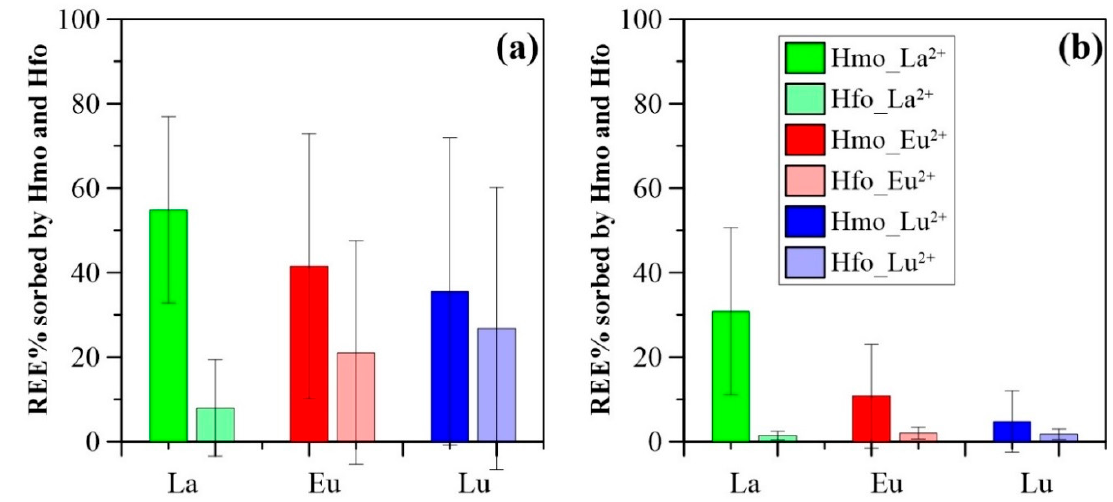
Figure 9. Comparison of sorbed La, Eu, and Lu by HMO and HFO for ( a ): shallow groundwater and ( b ): deep groundwater (The sorbed La, Eu, and Lu were determined by modeling).